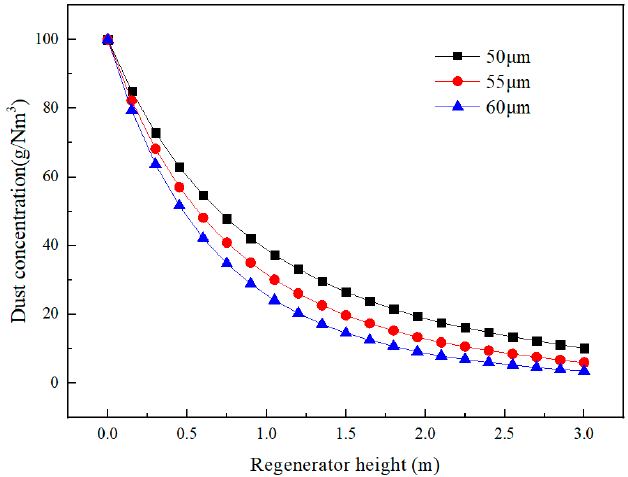
Figure 4. Change curves of concentration of different diameter dust.